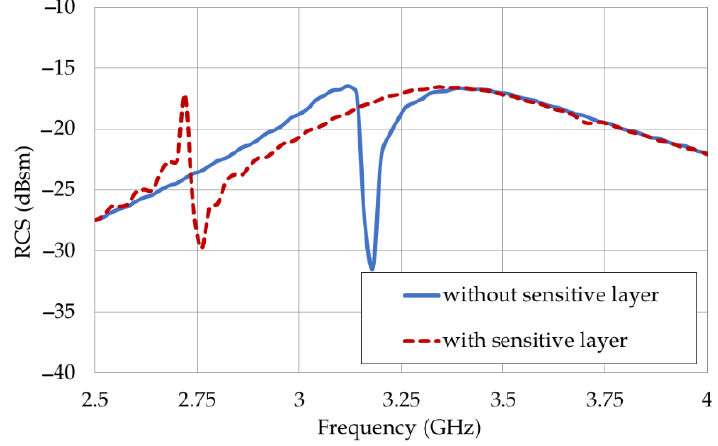
Figure 2. Simulated RCS of the chipless RFID tag with and without the sensitive layer.